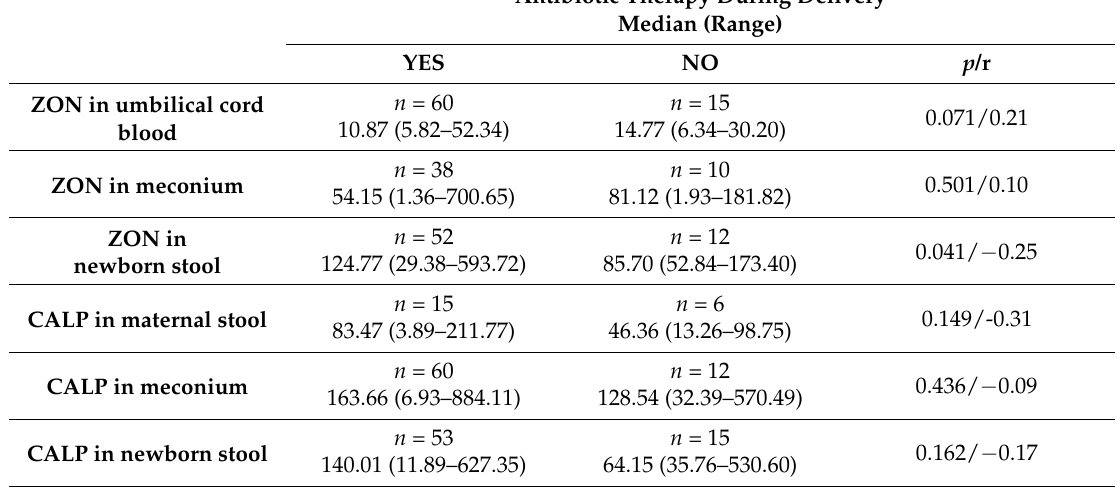
Table 5. Effects of antibiotic therapy during delivery on zonulin (ZON, ng/mL) and calprotectin (CALP, µ g/mL) concentrations.